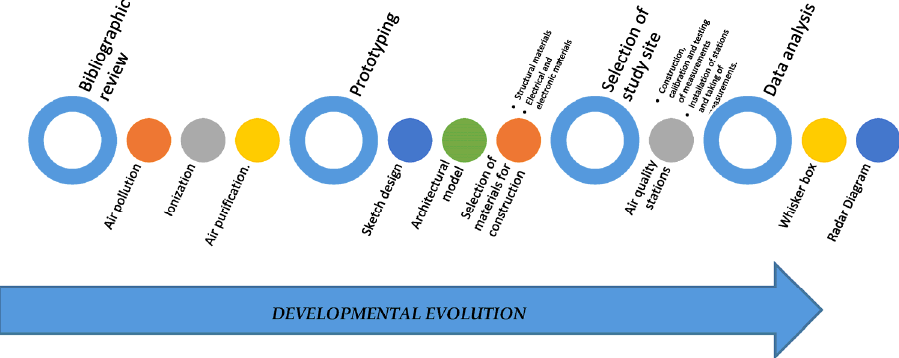
Figure 5. Detail of the methodology followed for the development of the ionizing lattice.